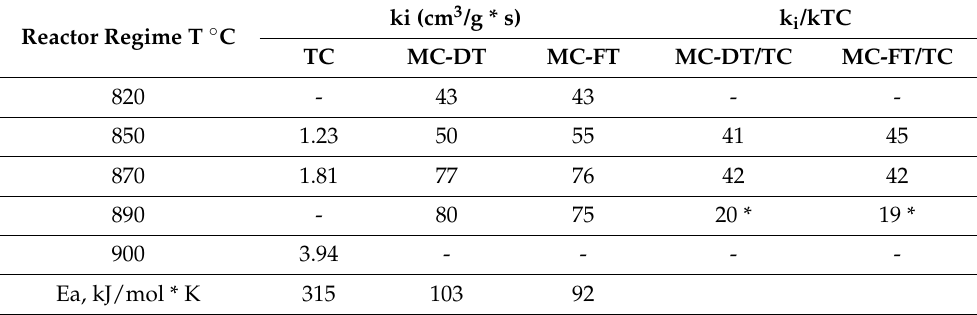
*—ratio of constants in a reactor with MC at T = 890 ◦ C to a constant in a traditional reactor at T-900 ◦ C, Legend in the table: TC—traditional catalyst, MC-DT—membrane catalyst (mode of “diffusion” transport), MC-FT— membrane catalyst (mode of “forced” transport), k i —reaction (R2) rate